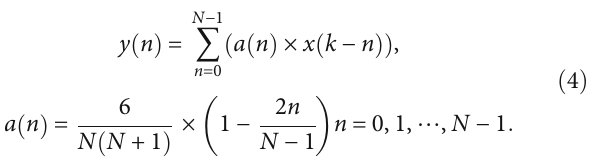
fi lter with constant coe ffi cients. Its implementation principle is shown in Figure 6.